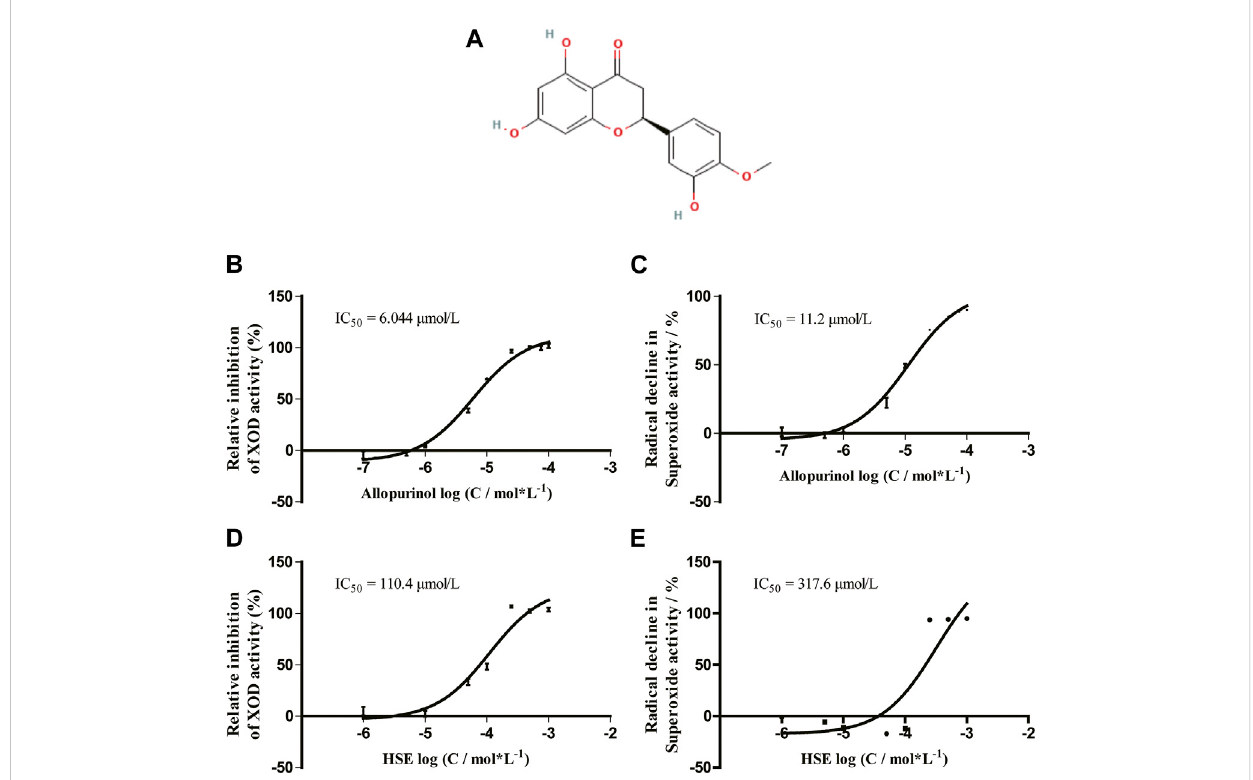
FIGURE 1 Chemical structure of hesperetin (HSE) (A) and its dose-response curve on xanthine oxidase (XOD) activity (D) and scavenging of superoxide anions (E) in vitro . Data are the mean ± SEM (n = 3) and representative of three independent experiments. The effect of allopurinol on XOD activity (B) and scavenging of superoxide anions (C) are shown. HSE, hesperetin; XOD, xanthine